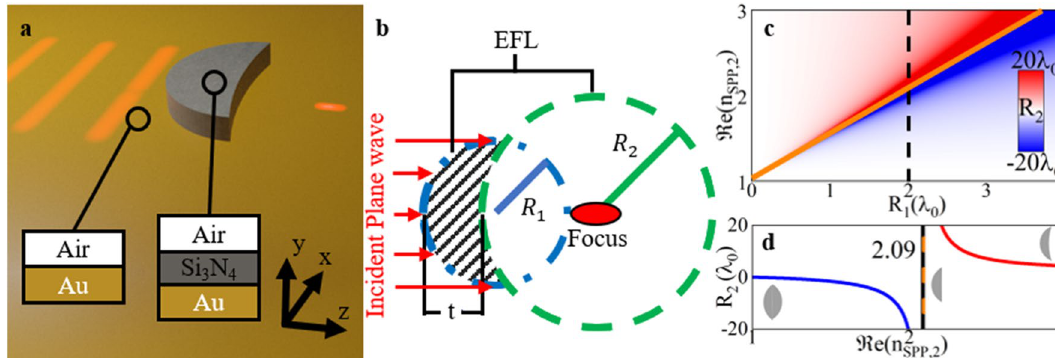
Figure 1. ( a ) Artistic representation of the proposed plasmonic meniscus lens. The insets represent the material compositions of the two regions where region 1 is air-Au (IM) and region 2 is air-Si 3 N 4 -Au (IIM). ( b ) Schematic representation of the lens maker equation used to design the plasmonic meniscus lenses, where R 1 and R 2 are the radii of curvature of the input and output surfaces of the lens, respectively, t is the lens thickness along the z -axis at x = y = 0 and EFL is the effective focal length, the length from the second principal plane of the lens to the maximum of the focus. ( c ) Analytical values of R 2 representing the transition from negative values (blue), biconvex lens, to infinity (orange line), convex-planar, to positive values (red), meniscus, as R 1 and ℜ e (cid:31) n SPP ,2 (cid:30) vary. The colour bar inset represents the values of R 2 . The black dashed line shows when R 1 = 2 λ 0 . ( d ) Value of R 2 along the dashed black line in ( c ) considering R 1 = 2 λ 0